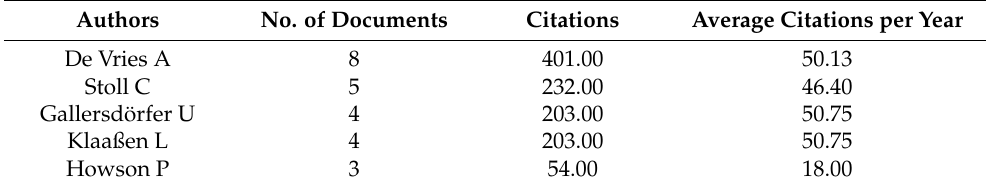
Figure 5. Development of the Literature. Table 3. Top 5